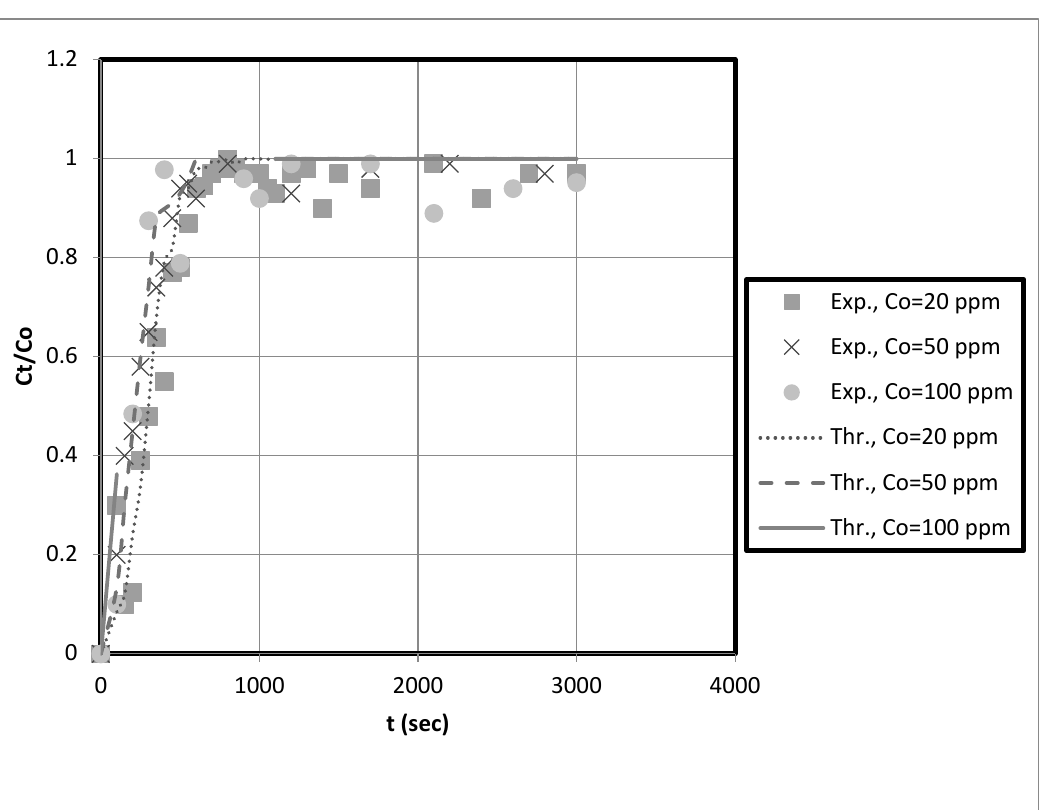
Figure 11. Axial pore diffusion model fit of the fixed-bed breakthrough curve for copper at different initial solution concentrations. Conditions: h = 0.05 m, us = 0.00473 m/s, kf = 0.000173 m/s, Dp = 2 × 10 − 9 , Dax = 3.53 × 10 − 6 m 2 /s, eb = 0.42, r = 0.000175.